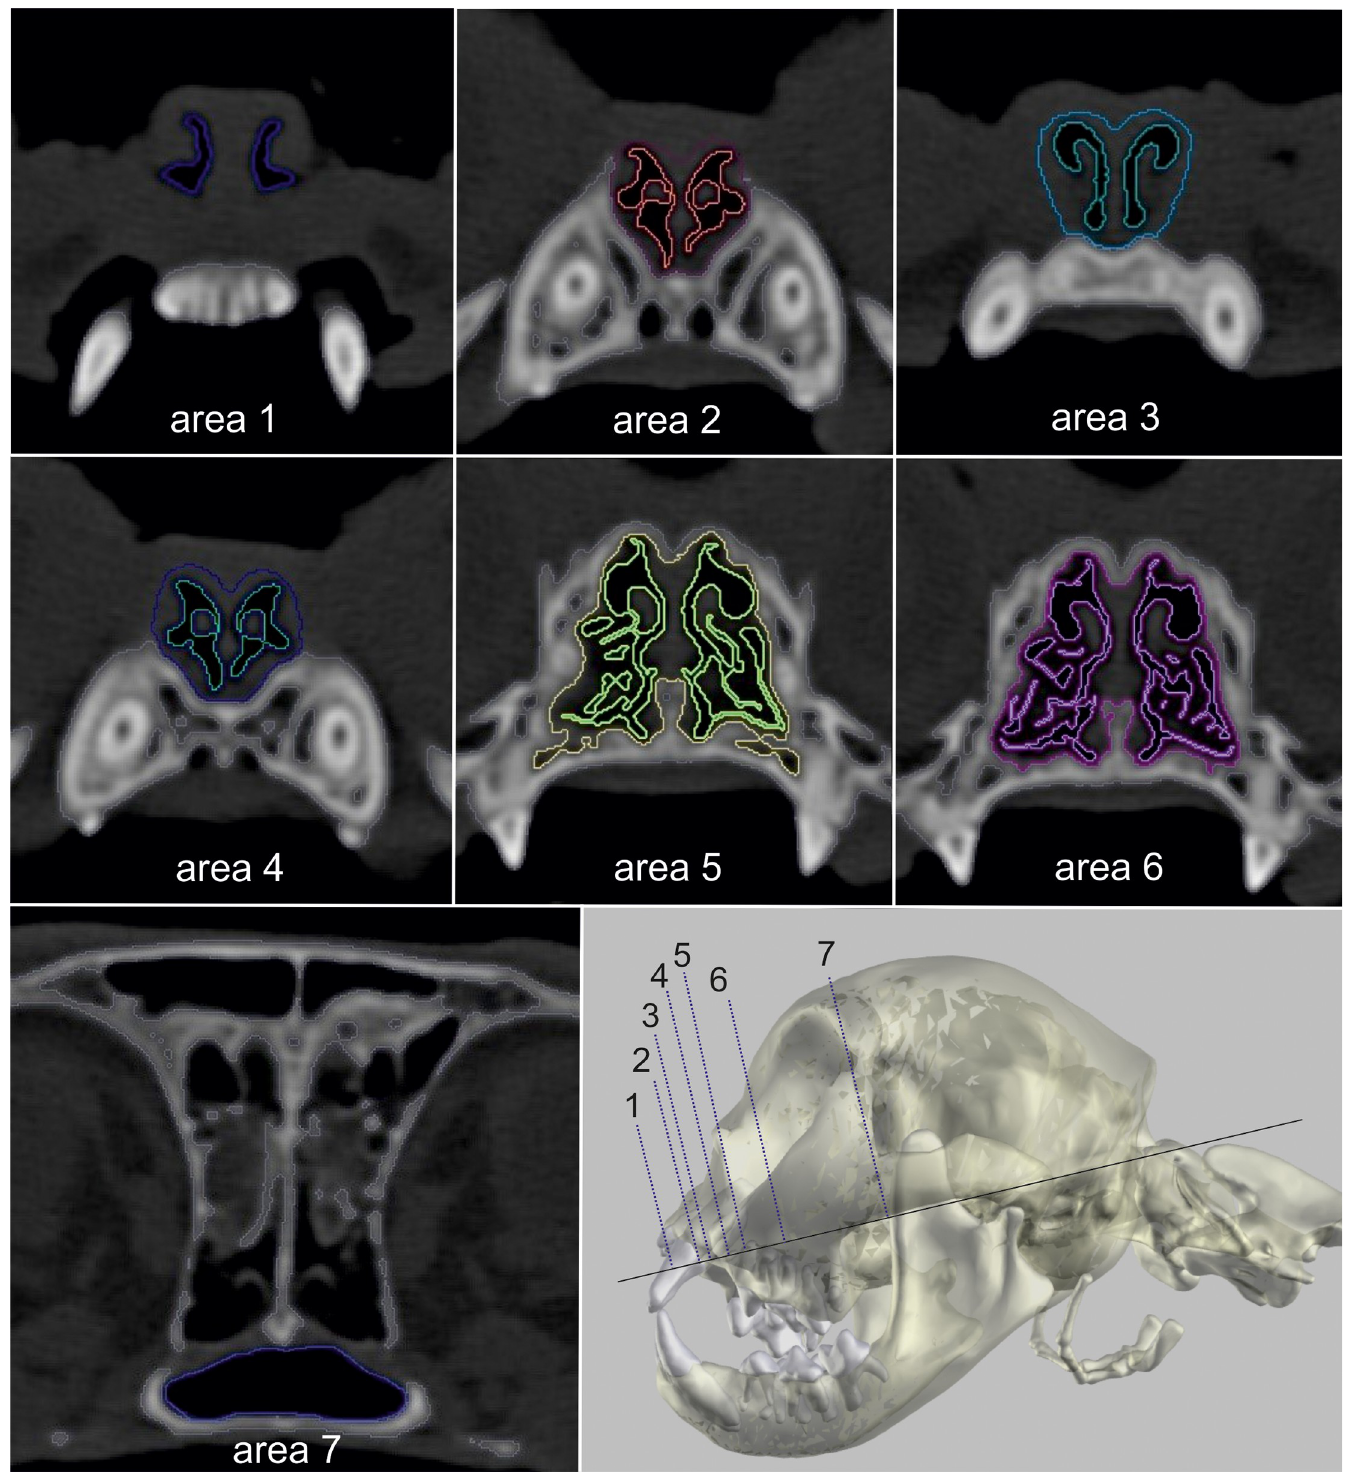
Fig 6. Measurement of the nasal airway passages in a Persian cat. Two-dimensional CT images in a transversal plane of the nasal cavity in a Persian cat with segmentation of the airway passages and the surrounding tissues.